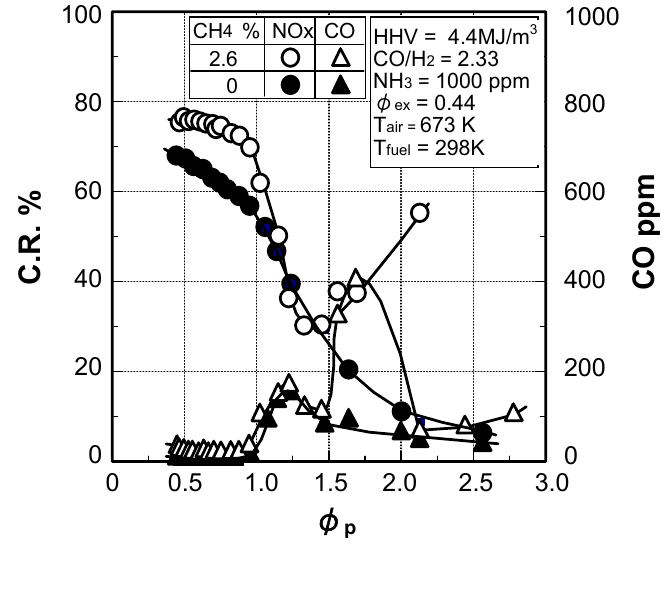
concentration on both conversion rate characteristics and CO Figure 19. Effect of CH 4 emissions in two-stage combustion defining by